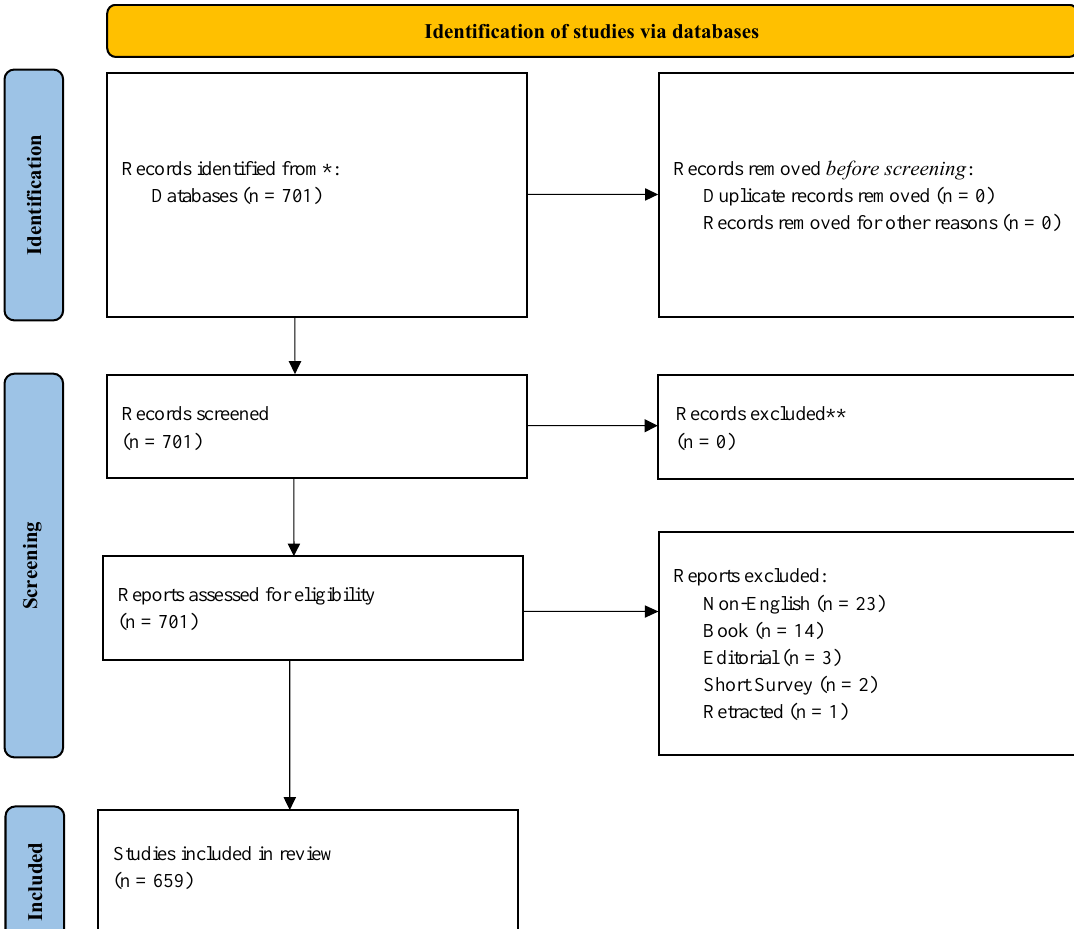
Figure 1. Flowchart of the data collection process adapted from the PRISMA